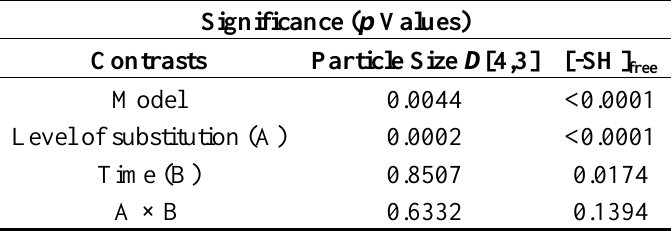
Table 2. Summary of the significance of the effects of WBAP and time on the response of milk to heating, as calculated by analysis of variance ( n = 3).